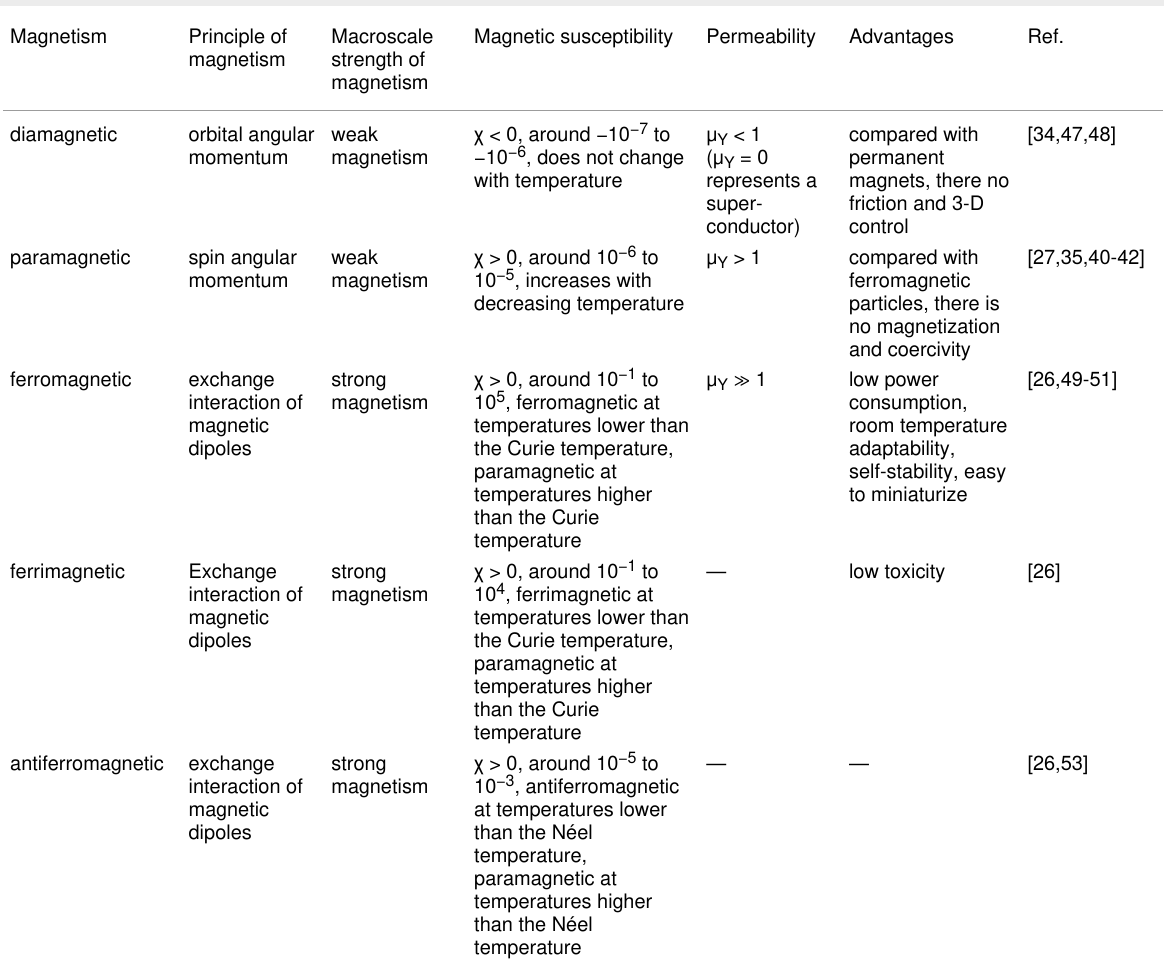
Table 1: Magnetic materials for